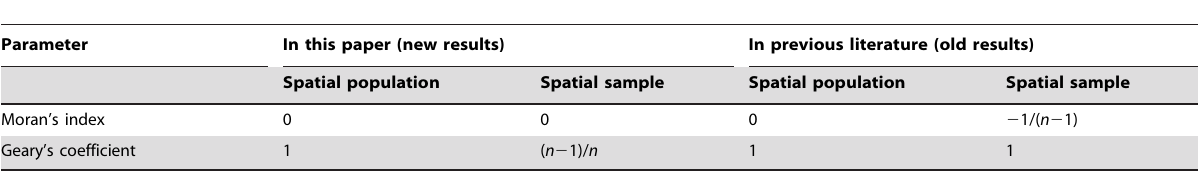
Table 1. The threshold values of Moran’s index, Geary’s coefficient and the revised results.